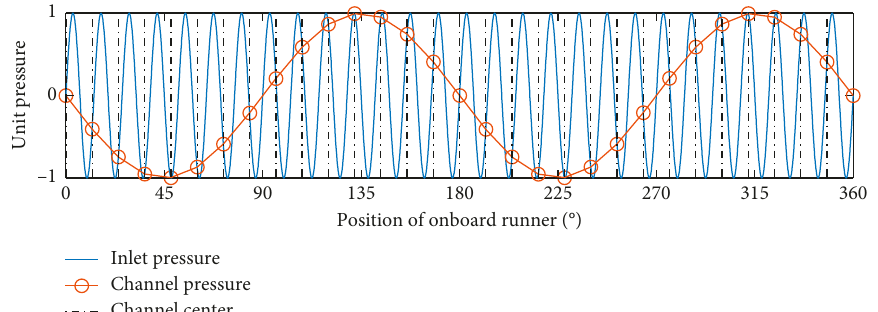
Figure 1: Instantaneous illustration of the DM2 excitation. A sinusoidal signal with 28 periods is divided into 30 equal segments. The intersection line for each segment represents the pressure in each of the 30 runner channels. By plotting a curve through the intersection points, the overall pressure with 2 diametral modes appears.